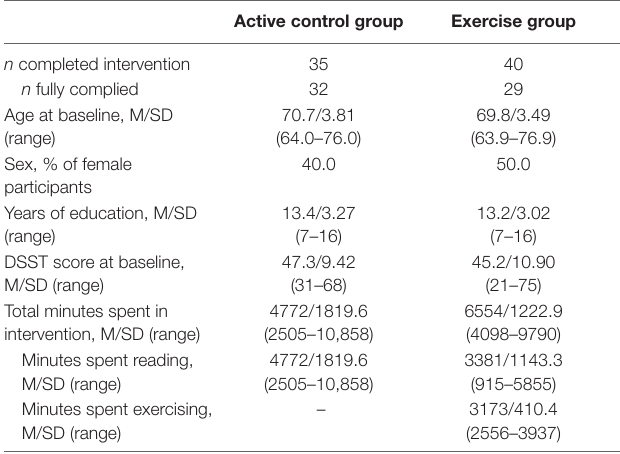
TABLE 1 | Sample demographics and intervention specifics.